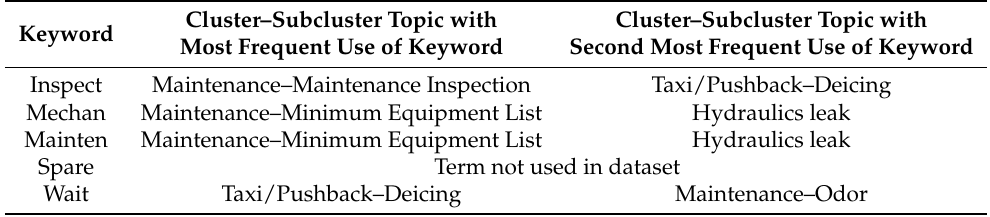
Table 3. Subclusters ranked by frequency of maintenance-related